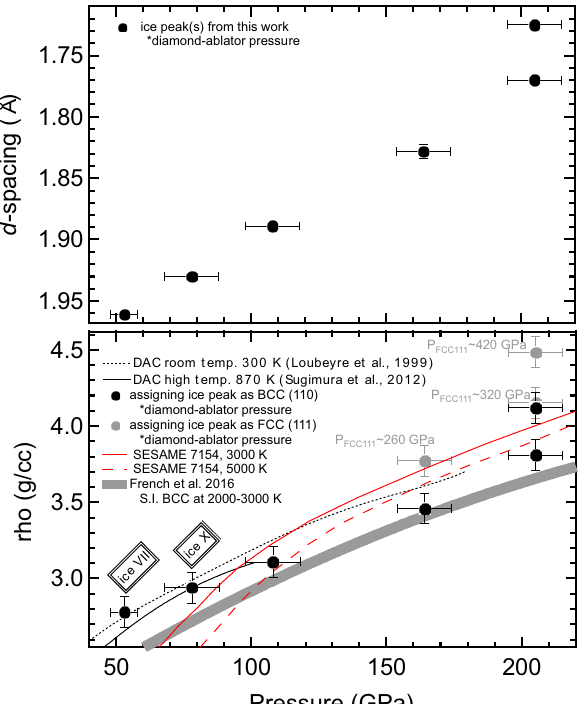
Figure 3. Comparison of d -spacing and density for different structures. Measured d -spacings for each ice peak plotted with the pressures derived from the diamond-ablator XRD signal (top graph). Black circles (bottom graph) show density trend with pressure assigning this peak as the BCC (110). Dotted black line is the Vinet fit to room temperature, static compression DAC work Loubeyre et al. 40 . Solid black line is the trend for high temperature DAC data Sugimura et al. 35 . We note a reasonable similarity with this trend and the DFT prediction from French et al. (Ref. 25 ; solid grey line) for a superionic BCC structure of ice below 200 GPa, but above there is some discrepancy. Red curves are from SESAME 7154 (Ref. 26 ) for 3000 K and 5000 K, solid and dashed, respectively. Assigning the same d -spacing peak to FCC (111) (grey circles) shows a marked jump in density using the diamond-ablator based pressure which does not fit any predicted trend, nor do we have the corresponding FCC (200) peak which would be in the detector range. If we use French et al. 25 EoS for superionic FCC ice to determine pressure of the ice, there would be a marked jump in pressure which does not corroborate the diamond-ablator pressure, or velocimetry-based pressure or laser drive intensity-pressure calibration